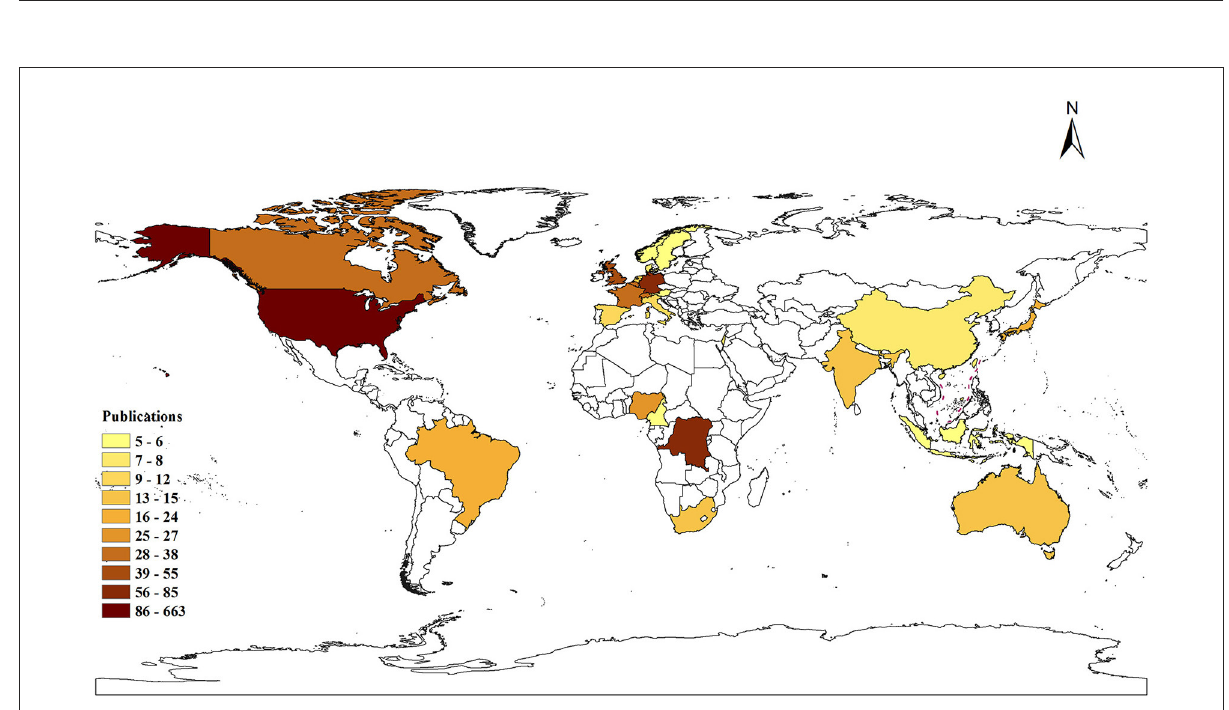
FIGURE8 Global distribution of monkeypox literatures. The color of each country or region on the world map represents the number of literature published, according to the color gradient in the lower left